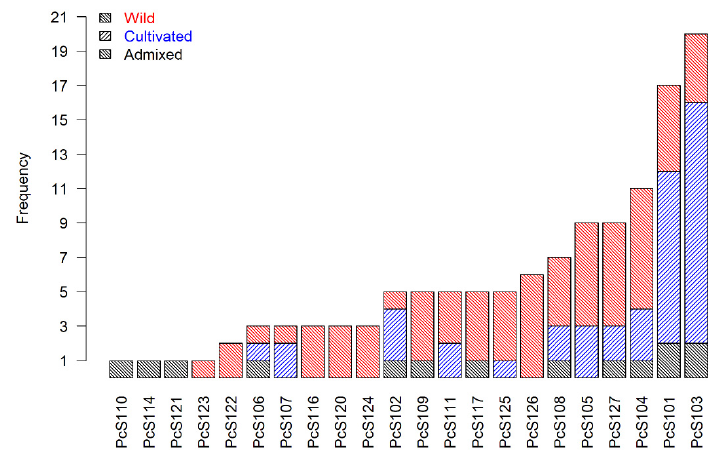
Figure 1. S -Allele frequency among analyzed accessions according to their population structure information shown in Bennici et al. (2018) [17]. Samples without an assigned subpopulation are excluded.